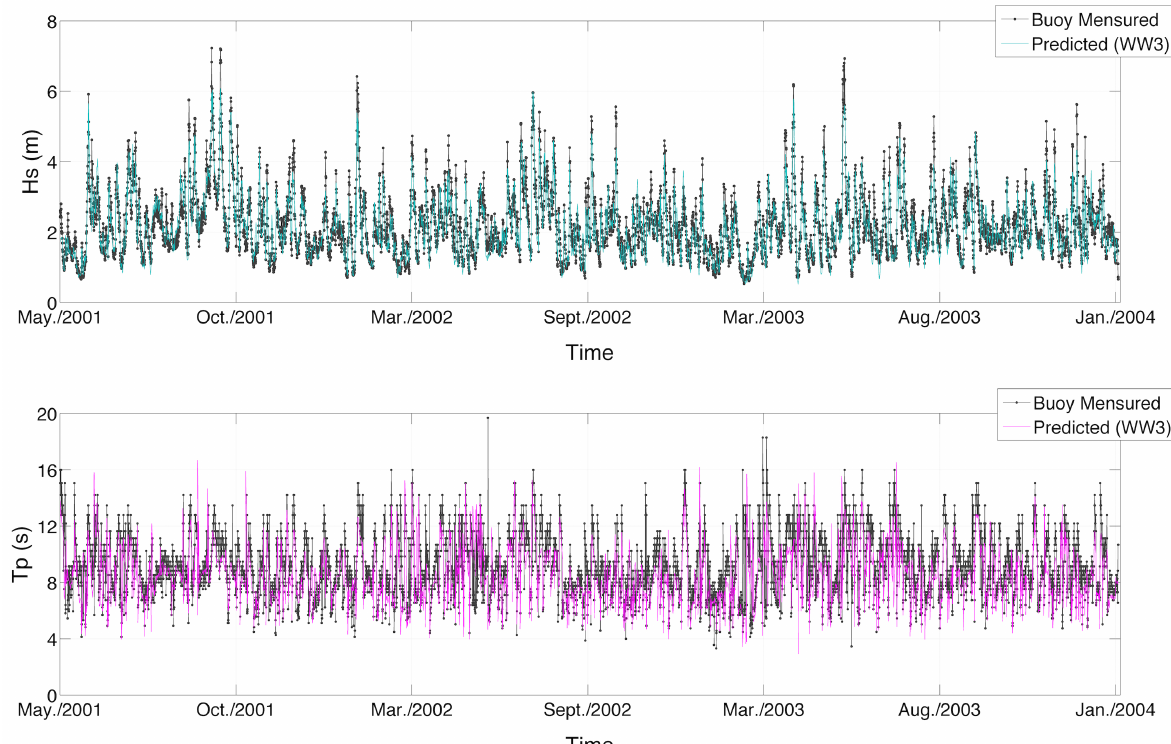
Figure 2. The time series for Hs and Tp, where the dotted line is the Minuano buoy record; the blue and pink lines represent the Hs and Tp from WW3 respectively.